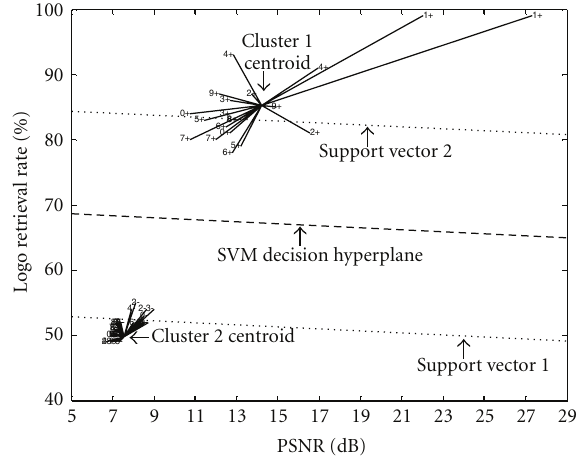
Figure 10: SVM classification and K -means clustering results by the existing TROI-based scheme [12]. Note that the distance between support vectors by SVM [27] is d = 5 . 1 and cluster 1 and cluster 2 are positive and negative clusters, respectively, by K -means clustering algorithm [28]. Attack numbers 0–9 are referred using